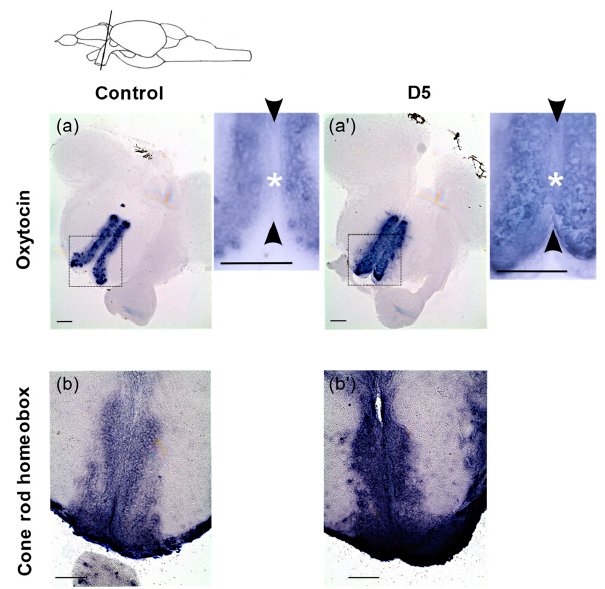
Figure 7. RNA in situ hybridization on adult brain sections showing expression of oxt and crx expressing cells. ( a , a ′ ) Coronal sections of brain showing expression of oxt in the anterior parvocellular preoptic nucleus (PPa) in control and 5mGy/(D5) irradiated fish. The black rectangle represents the area for the higher magnification images. ( b , b ′ ) Expression of crx in the PPa in the control and after irradiation at 5 mGy/h(D5). The black arrow heads delineate the ventricular zone (VZ) in the medial ventricular zone of the PPa and the white asterisk represents the location of VZ progenitors where ectopic expression is detected. Scale bar = 100 µ m. The scheme at the top represents the location of the coronal sections in the